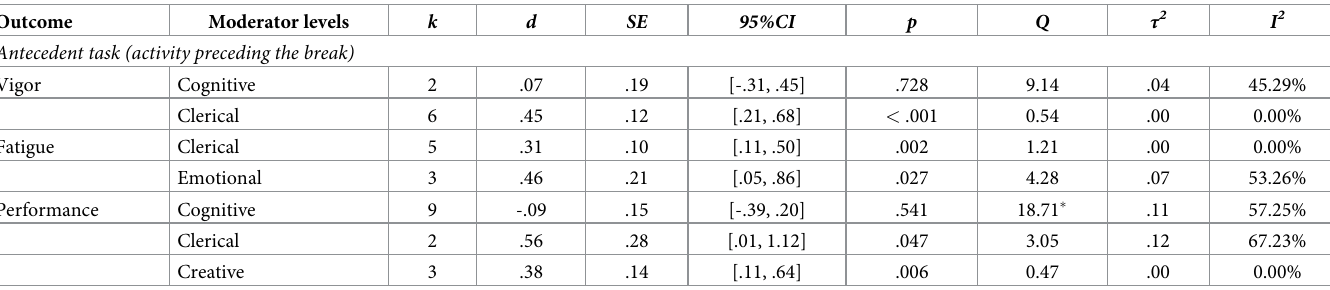
Table 5. Meta-analytical findings at each level of the antecedent task